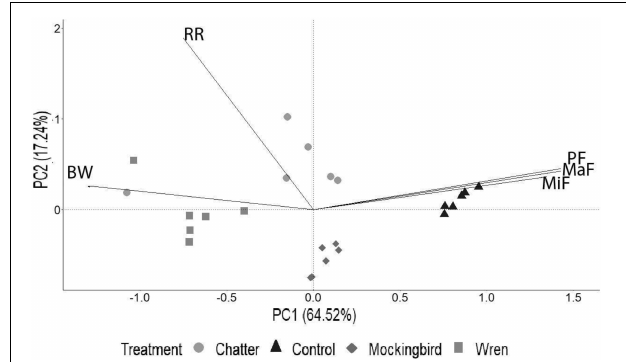
FIGURE 3 | Principal components analysis biplot of acoustic variables used in the playback treatments (shiny cowbird chatter call and wren, mockingbird, and saffron finch adult calls). The first and second principal components were plotted in an x – y plane and accounted for 64.52 and 17.24%, respectively, of the total variance. BW, bandwidth; RR, repetition rate; MiF, minimum frequency; MaF, maximum frequency; PF, peak